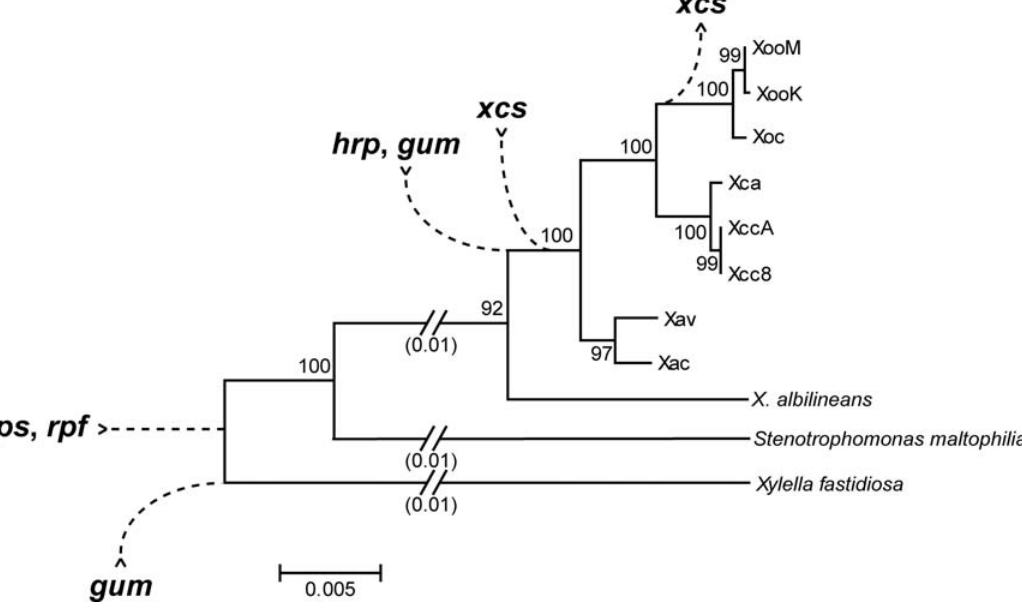
Figure 4. Inferred pattern of acquisition or loss of five pathogenesis-associated gene clusters in Xanthomonas . Based on comparison of genome sequences and other data among Xanthomonas strains and the close relatives Xylella fastidiosa and Stenotrophomonas maltophilia (see text), an inferred pattern of acquisition or loss of five pathogenesis associated gene clusters during the evolution of different Xanthomonas lineages is shown, superimposed on a phylogenetic tree drawn from an alignment of 16s rRNA gene sequences. Potential horizontal exchange of hrp and rpf sequences affecting the X. axonopodis clade, discussed in the text, is not depicted. Strain abbreviations are as in the text. For X. fastidiosa , the strain 9a–5c sequence was used. For S. maltophilia , the strain K279a sequence was